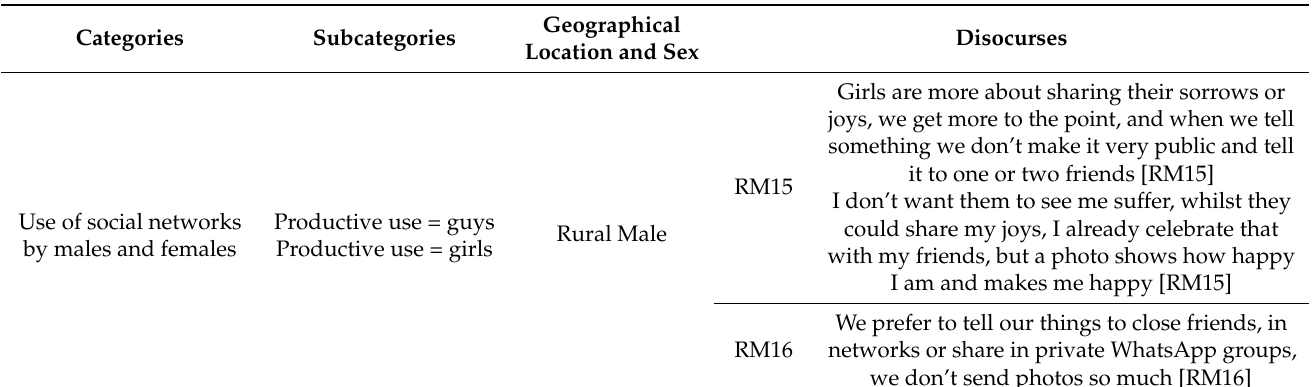
Table 7. Expression of feelings in social